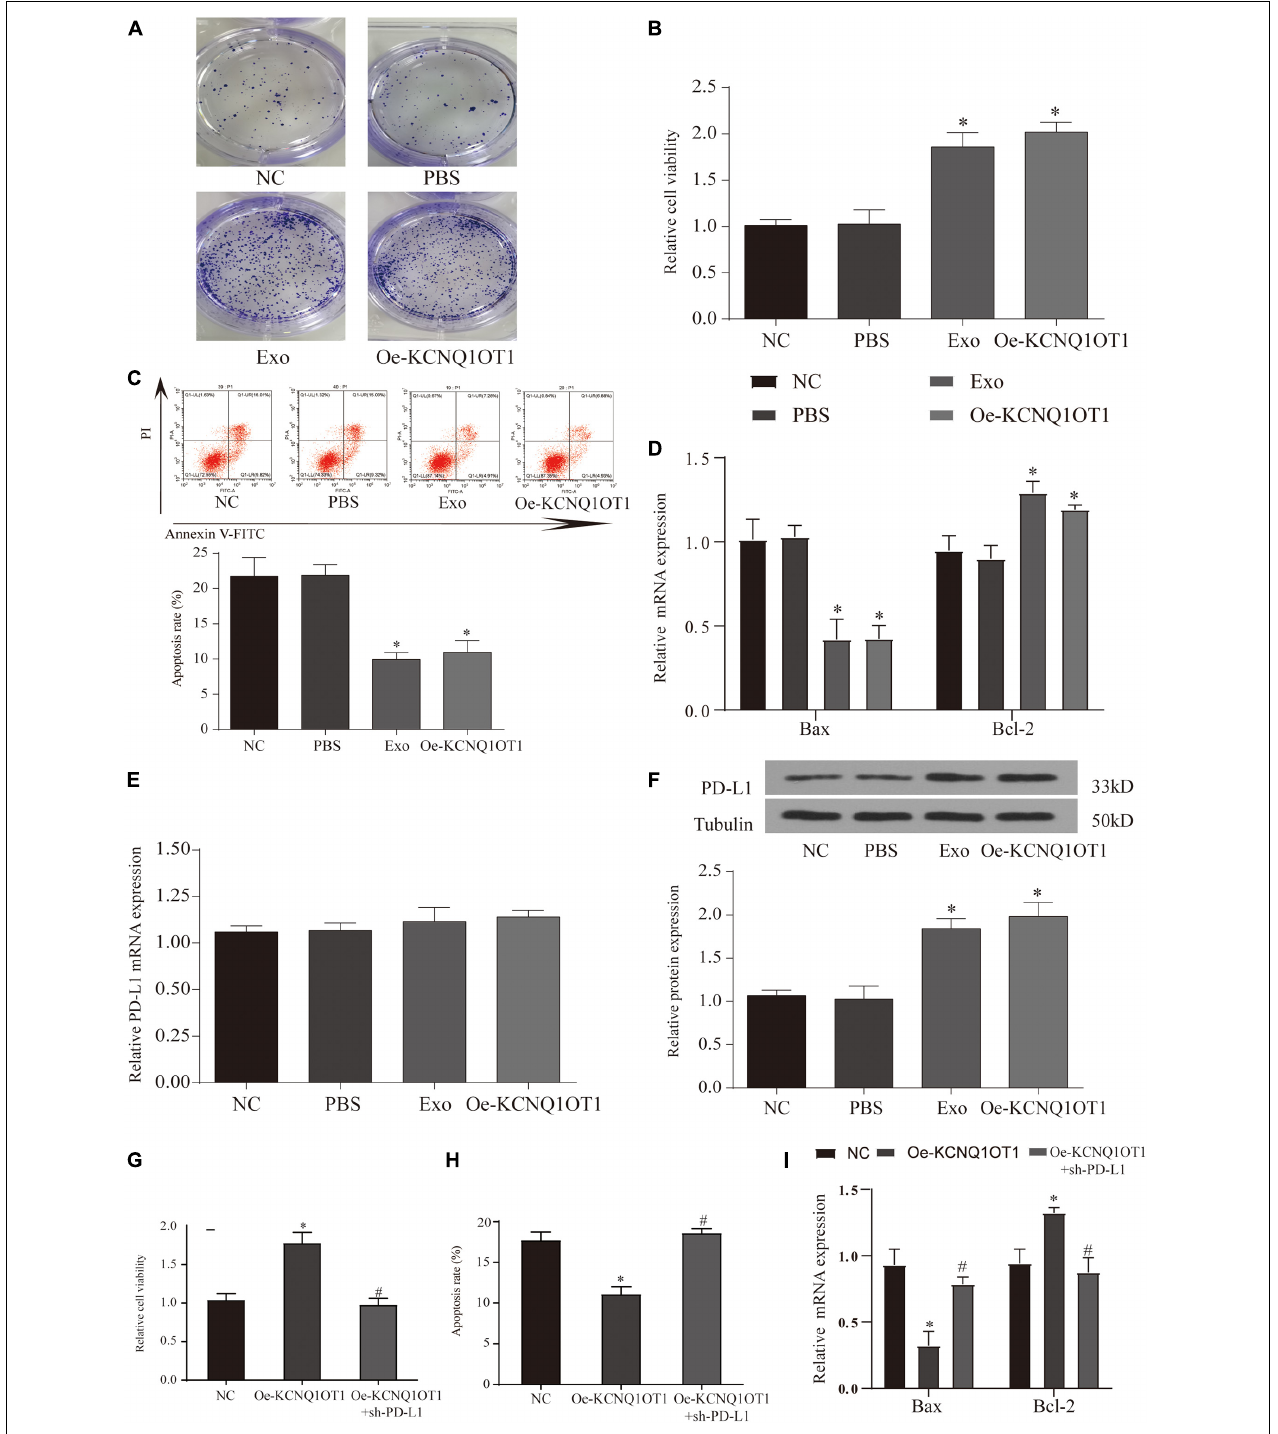
FIGURE 6 | Long non-coding RNA (lncRNA) KCNQ1OT1 regulates tumor immune escape through programmed death-ligand 1 (PD-L1). (A) Activated T cell and SW1463 cells were cocultured in six-well plates for 7 days, and then surviving SW1463 cells were visualized by colony formation assay. (B) T cell-mediated SW1463 cell killing analysis measured by Cell Counting Kit (CCK)-8 assay. (C) Cell-mediated SW1463 cell killing analysis measured by apoptosis detection. (D) Cell-mediated SW1463 cell killing analysis measured by apoptosis detection. (E,F) PD-L1 mRNA and protein expression of SW1463 cells in different treatment groups. (G) T cell-mediated SW1463 cell killing analysis measured by CCK-8 assay. (H,I) Cell-mediated SW1463 cell killing analysis measured by apoptosis detection. ∗ p < 0.05 compared with the NC/PBS group, # p < 0.05 compared with the Oe-KCNQ1OT1 group.